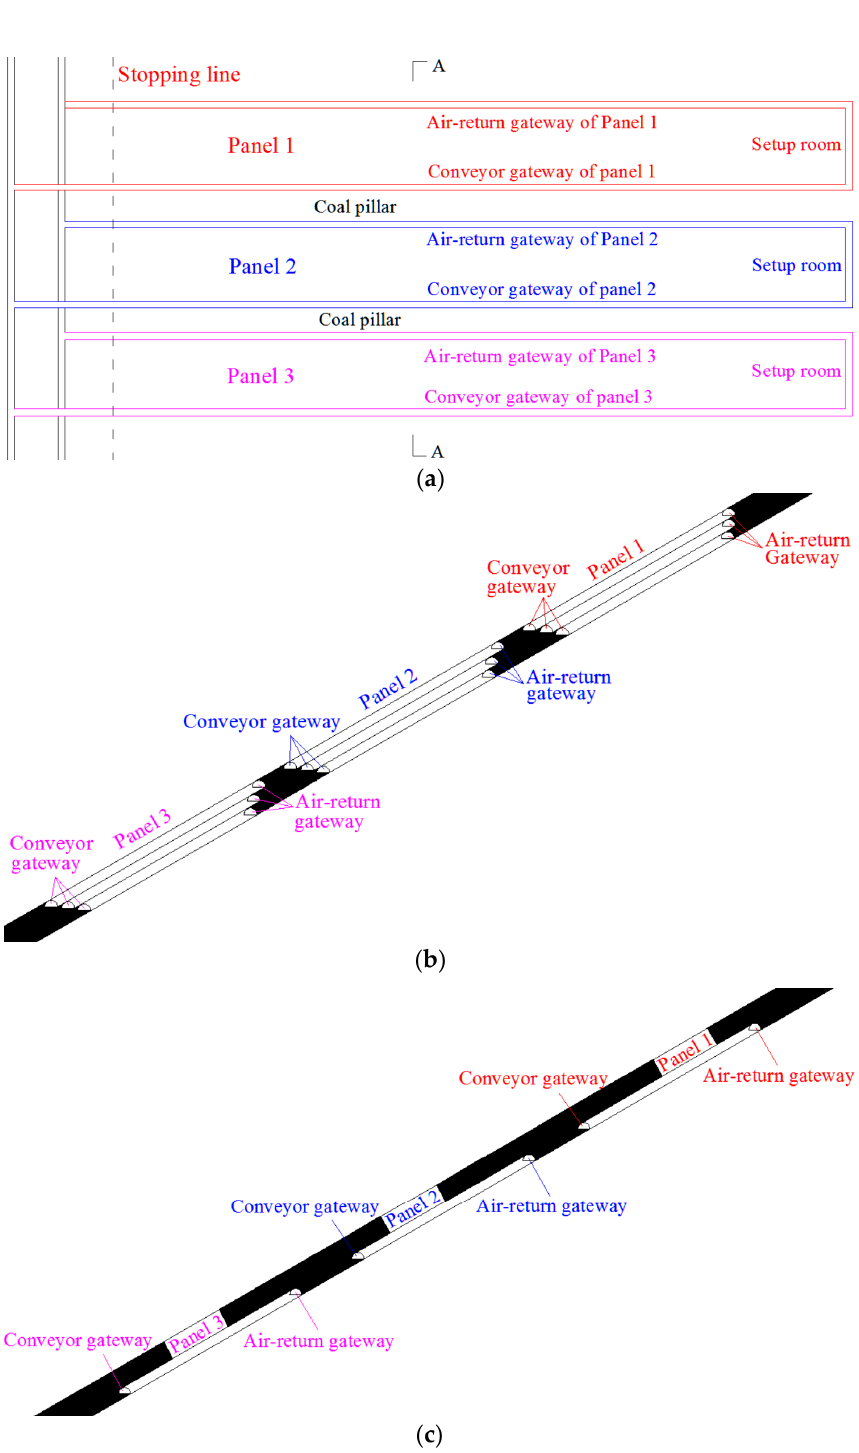
Figure 1. Conventional longwall mining system for Tangshan coal mine. ( a ) Plan view; ( b ) A-A section view of MLM (multi-slice longwall mining); ( c ) CLTCC (conventional longwall top coal caving).